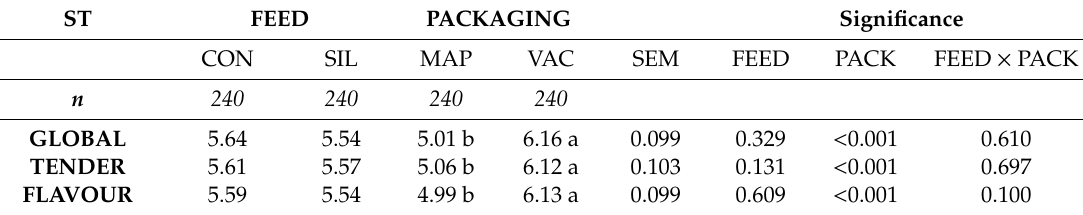
Table 8. E ff ect of feeding (concentrated (CON) vs. 70% maize silage + 30% concentrate (SIL)) and packaging (vacuum (VAC) and modified atmosphere (MAP)) on global, tenderness and